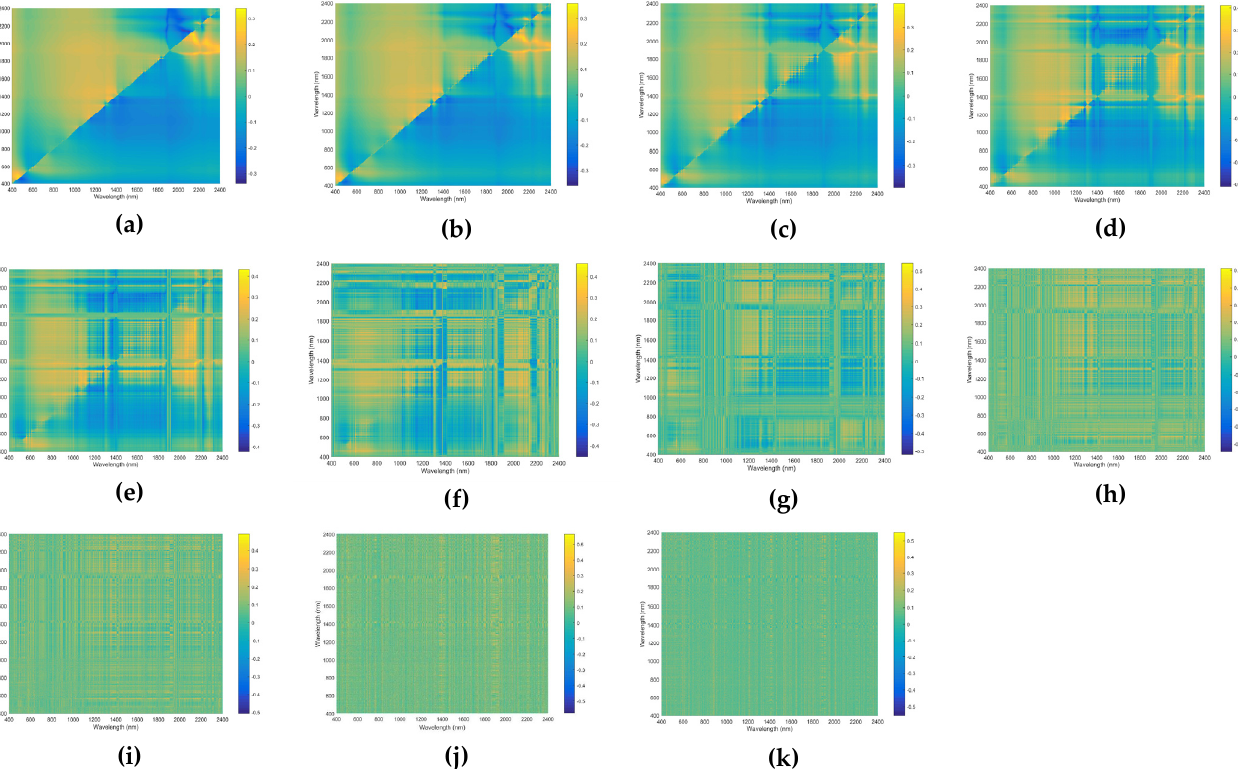
Figure A1. Correlation coefficients between soil Hg and ratio index of the reflectance processed by ( a ) 0-order, ( b ) 0.2-order, ( c ) 0.4-order, ( d ) 0.6-order, ( e ) 0.8-order, ( f ) 1-order, ( g ) 1.2-order, ( h ) 1.4-order, ( i ) 1.6-order, ( j ) 1.8-order, ( k )